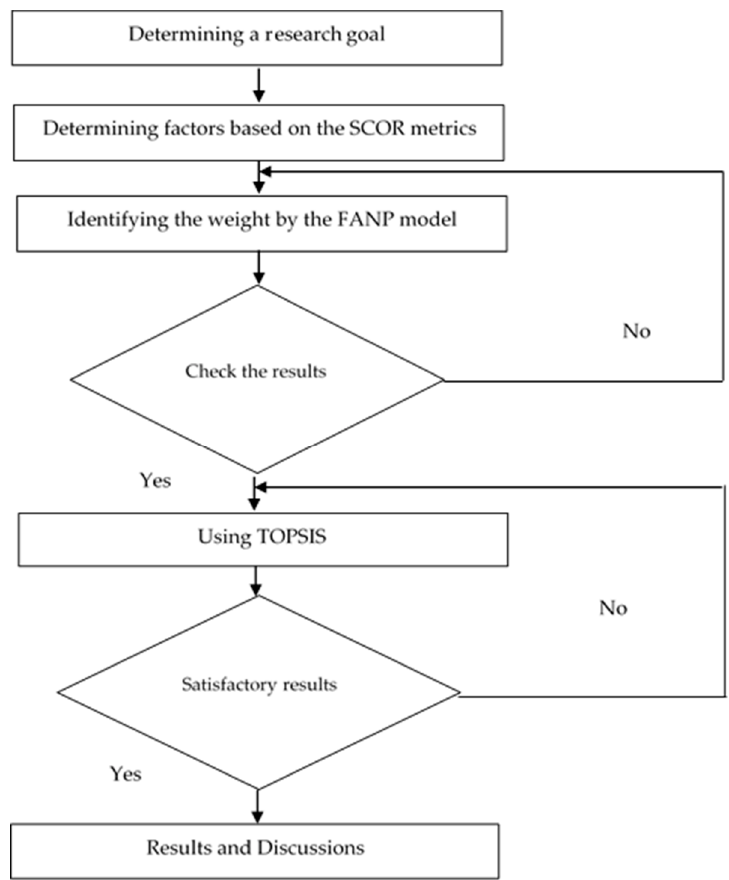
Figure 1. The research methodology.